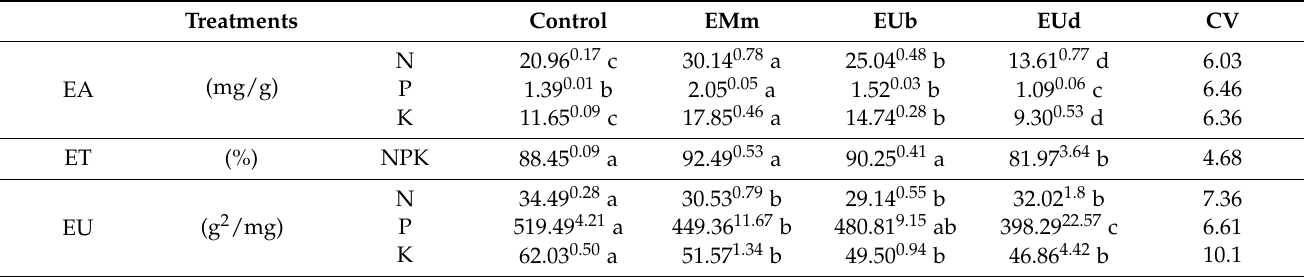
Table 4. Absorption efficiency (EA), transport (ET), and utilization (EU) of N, P, and K by the clonal eucalyptus hybrid I144 ( Eucalyptus urophylla × Eucalyptus grandis ) at 110 DAT.